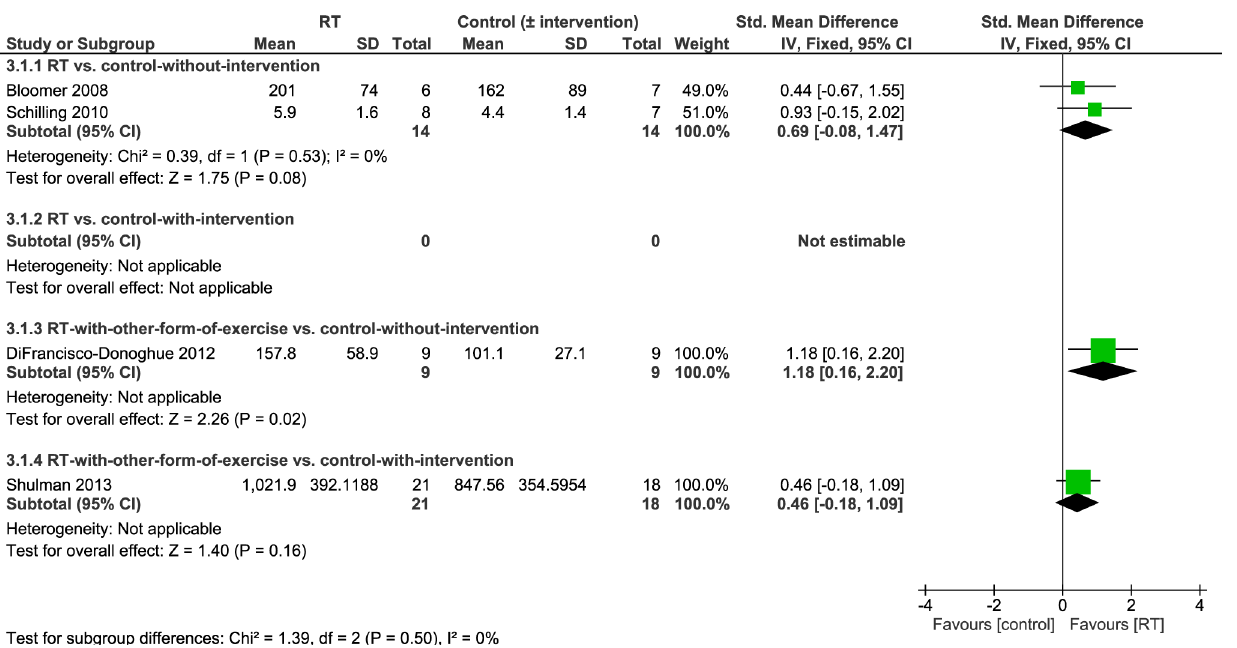
Fig 9. Subgroup analysis forest plot of comparison: RT vs. control-without-intervention, RT vs. control-with-intervention, RT with other form of exercise vs. control-without-intervention, RT with other form of exercise vs. control-with-intervention, using post-intervention values. Outcome: leg press strength. CI = confidence interval; IV = inverse variance; SMD = standardized mean difference.